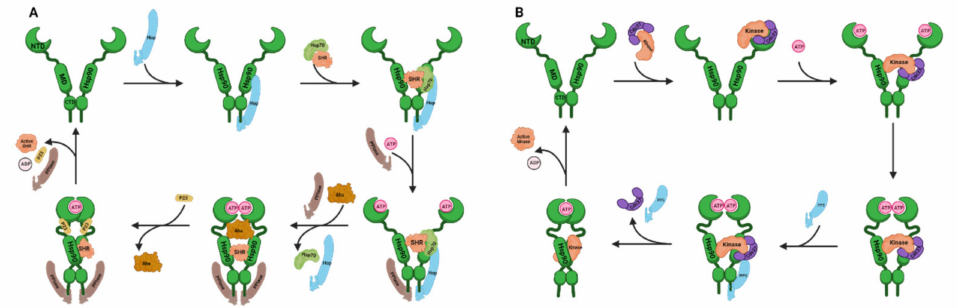
Figure 3. ( A ) Schematic illustration of Hsp90 chaperone cycles. Hsp90 includes three domains: the N-terminal domain (NTD), the middle domain (MD), and the C-terminal domain (CTD). Hsp90 homodimer undergoes ATP-regulated conformational rearrangements. ( A ) Hsp90-driven activation of steroid hormone receptors (SHRs). Hsp70–Hsp90 organizing protein (Hop, also known as stress- inducible phosphoprotein 1, Sti1) transfers unfolded SHRs from Hsp70 to Hsp90 and binds to one of the tetratricopeptide repeat (TPR)-acceptor sites of Hsp90 in the open state. The co-chaperone with peptidyl-prolyl cis-trans isomerase (PPIase) domain binds to the other Hsp90 TPR-acceptor site to form an asymmetric complex, and the binding of ATP leads to the Hsp90 intermediate state. Activator of Hsp90 ATPase homolog 1 (Aha1) promotes the formation of Hsp90 closed 1 state and accelerates ATPase activity. Co-chaperone p23 competes with Aha1 for binding to Hsp90 and stabilizes Hsp90 closed 2 state by reducing ATPase activity. After ATP hydrolysis, p23, the PPIase, and the active SHR are released. ( B ) Hsp90-driven activation of the protein kinases. After phosphorylation, Cdc37 captures the kinase to form a Cdc37–kinase complex that binds to Hsp90 NTD. In the presence of ATP, the Cdc37–kinase complex moves to Hsp90 MD, and Hsp90 transforms from an open state to a closed state. Then, protein phosphatase 5 (PP5) binds to Hsp90 CTD and dephosphorylates Cdc37. Finally, Cdc37, PP5, and active kinase are released, and Hsp90 returns to the open state for another cycle. Created with